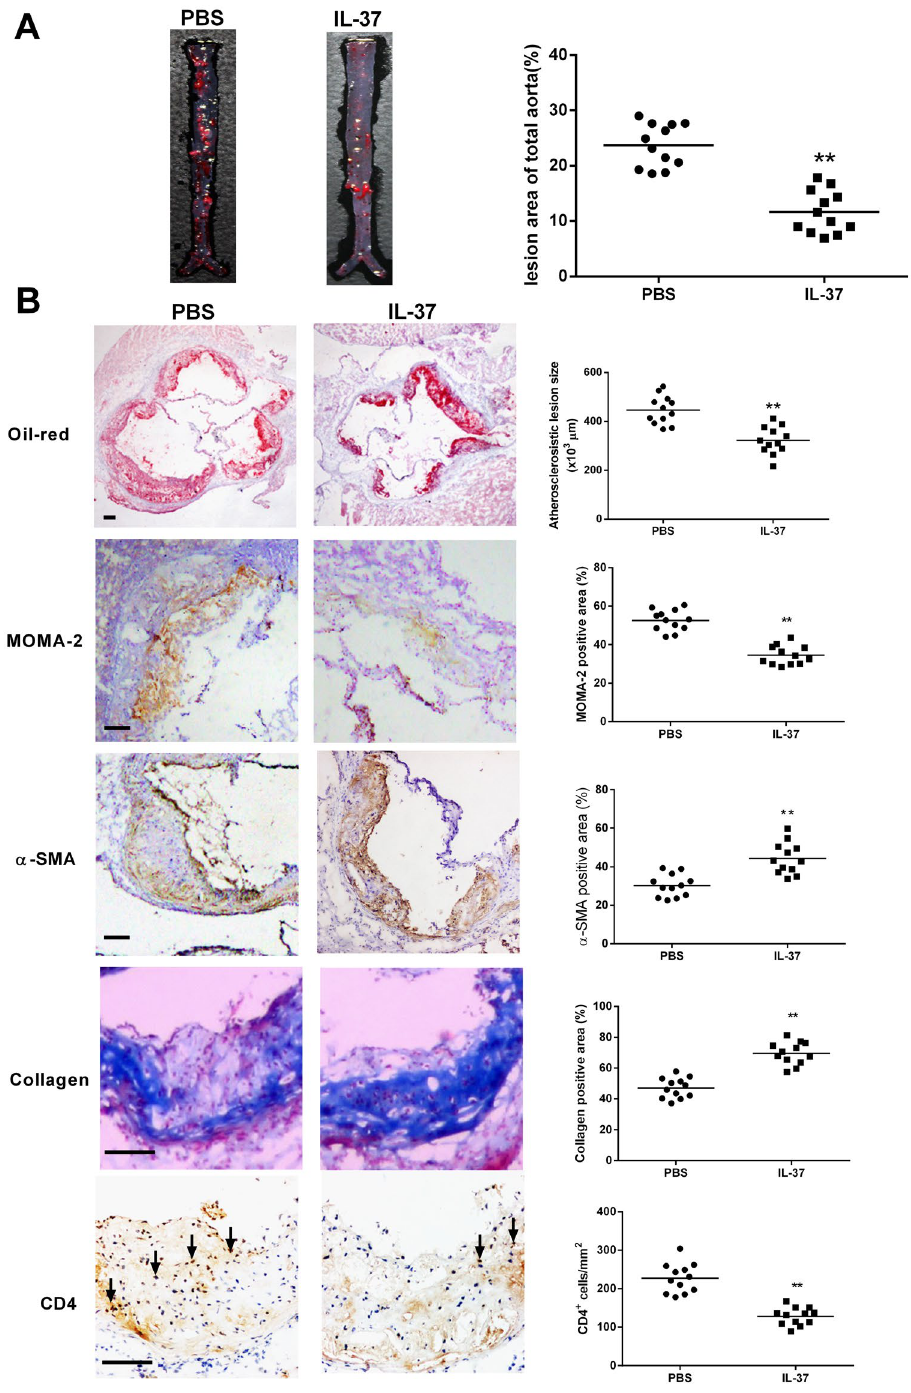
Figure 2. IL-37 ameliorates the development of atherosclerosis. ( A ) Representative photographs of Oil Red O staining in the surface lesion area of the entire aorta, and quantitative analysis of the percent lesion area of the entire vessel area ( * p < 0.05). ( B ) Representative sections of aortic sinus stained with Oil Red O (Black bar = 200 μ m), antibodies to MOMA-2 (Black bar = 200 μ m), α -SMA (Black bar = 200 μ m), collagen (Black bar = 200 μ m) and CD4 (Black bar = 200 μ m) staining in the two groups (Black bar = 200 μ m), and quantitative analysis of the lesion size of aortic sinus, MOMA-2, α -SMA, collagen and CD4 staining in the two groups. MOMA indicates monocytes/macrophages; SMA, smooth muscle actin. Values are presented as the means ± SEM, n = 12. ** p <